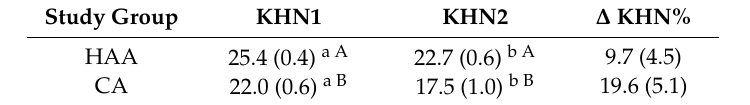
Table 2. Comparison of Knoop Microhardness for CA and HAA before and after solvent